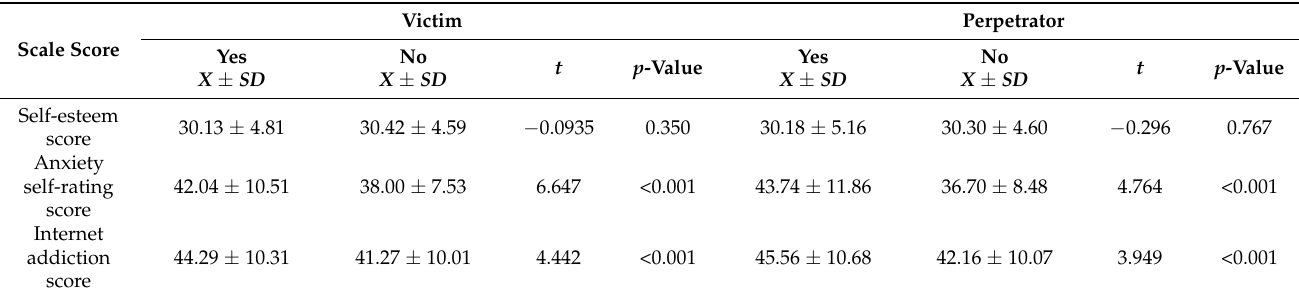
Table 2. Univariate analysis of cyberbullying in social media and self-esteem, anxiety and Internet addiction among college